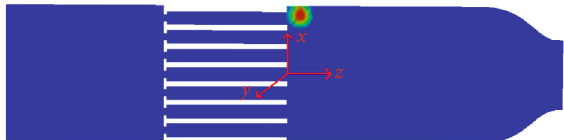
Figure 3: The imposed region of the constant volume bomb in the model